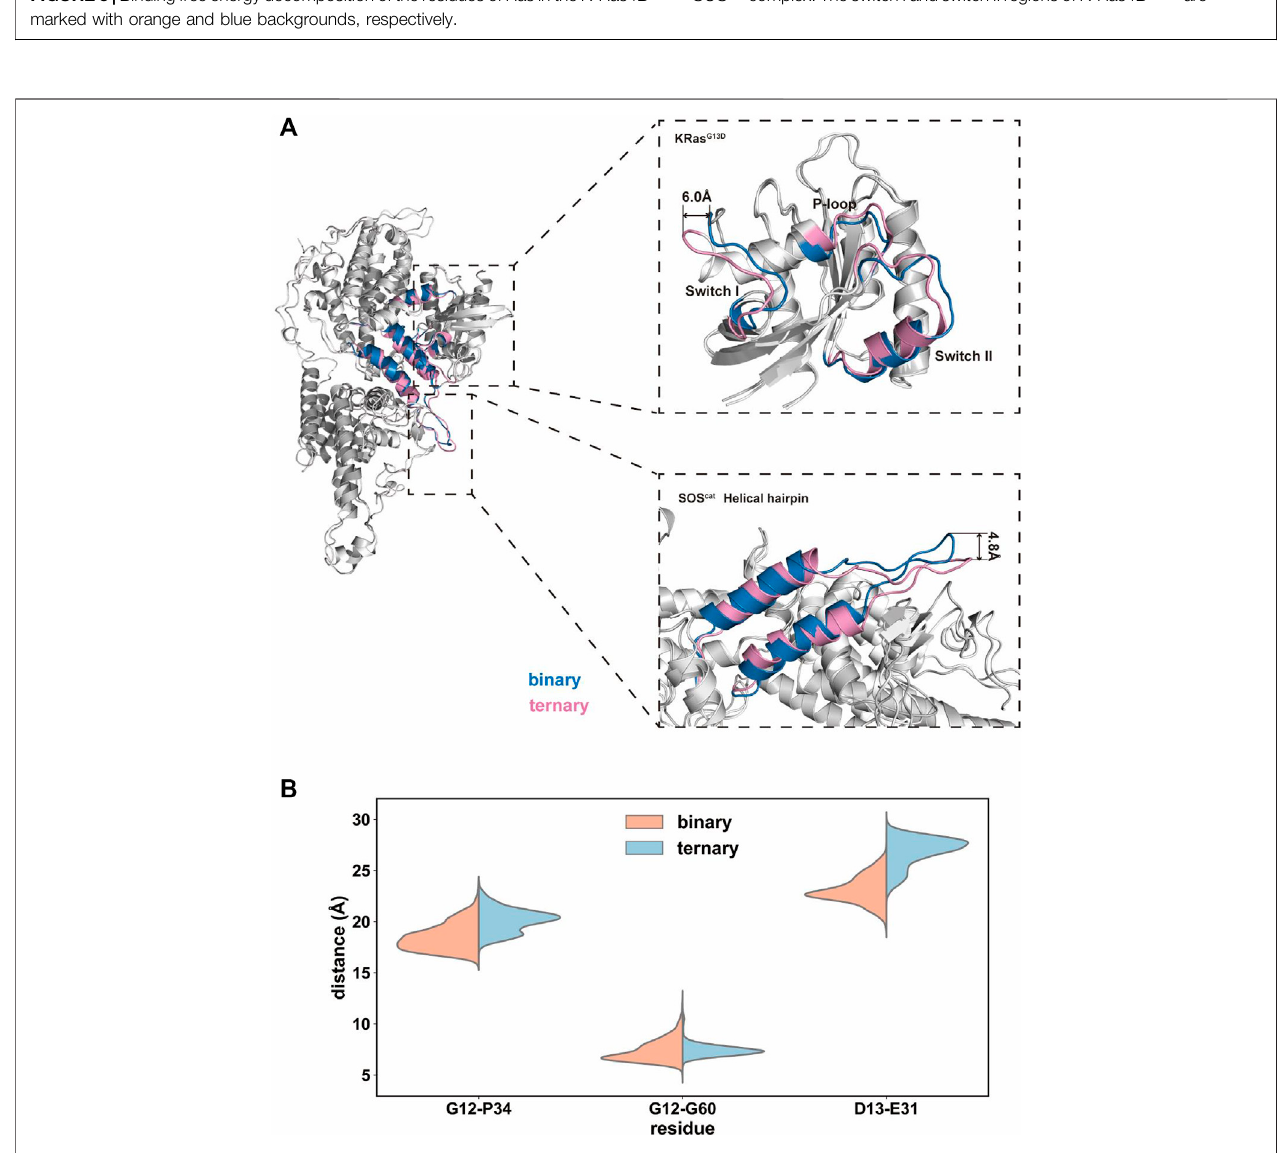
(cid:129) FIGURE 4 | Conformational dynamics of the K-Ras4B G13D SOS cat complex in the binary and ternary systems. (A) Representative structure of the (cid:129) K-Ras4B G13D SOS cat complex conformation in the binary (blue) and ternary (pink) systems. (B) Distance distributions of C α atoms between the G12 – P34, G12 – G60, and G13 – E31 residue